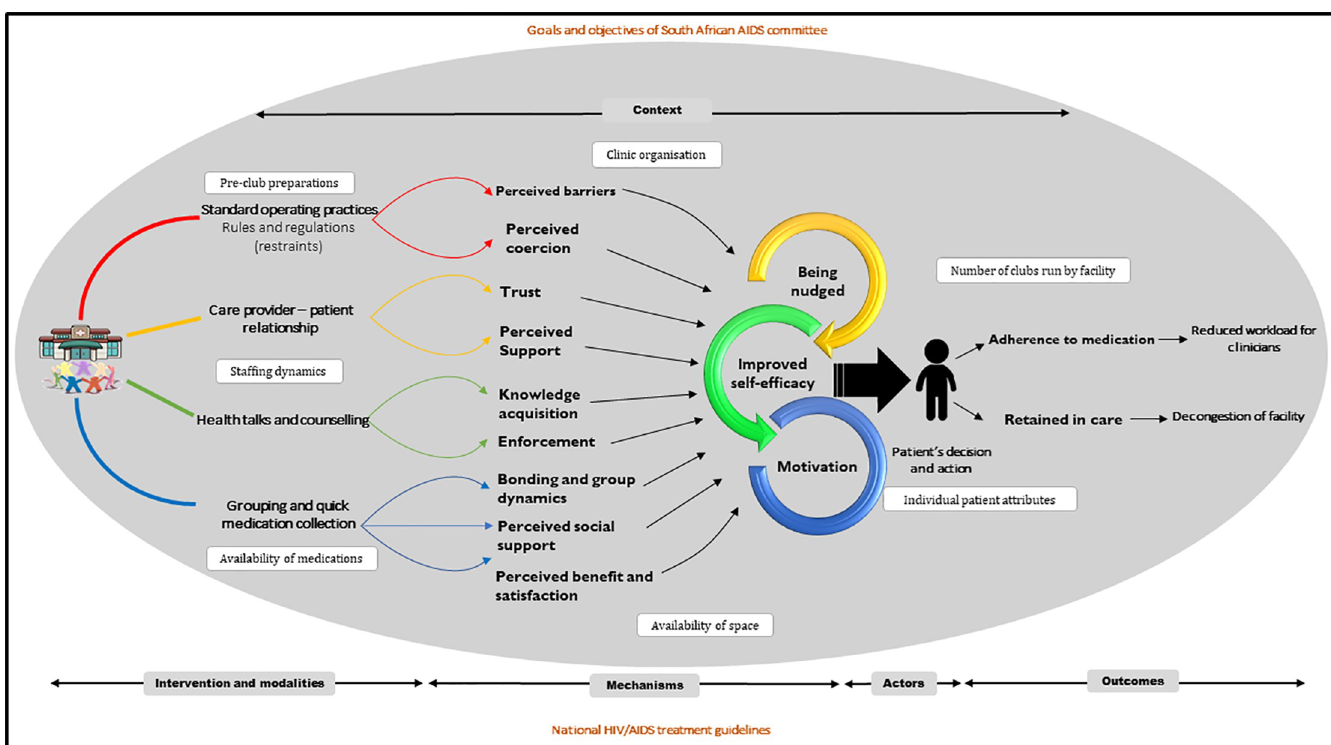
Fig 7. A modified configurational causation model of the adherence club